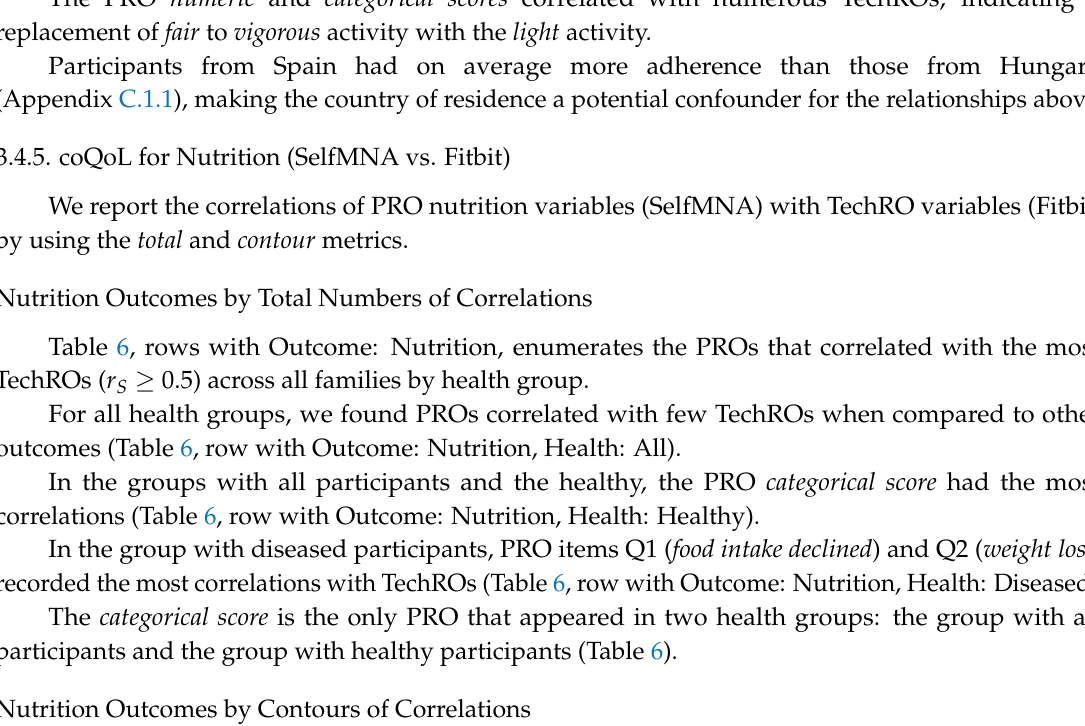
Table 6, rows with Outcome: Nutrition, enumerates the PROs that correlated with the most TechROs ( r S 0.5) across all families by health ≥